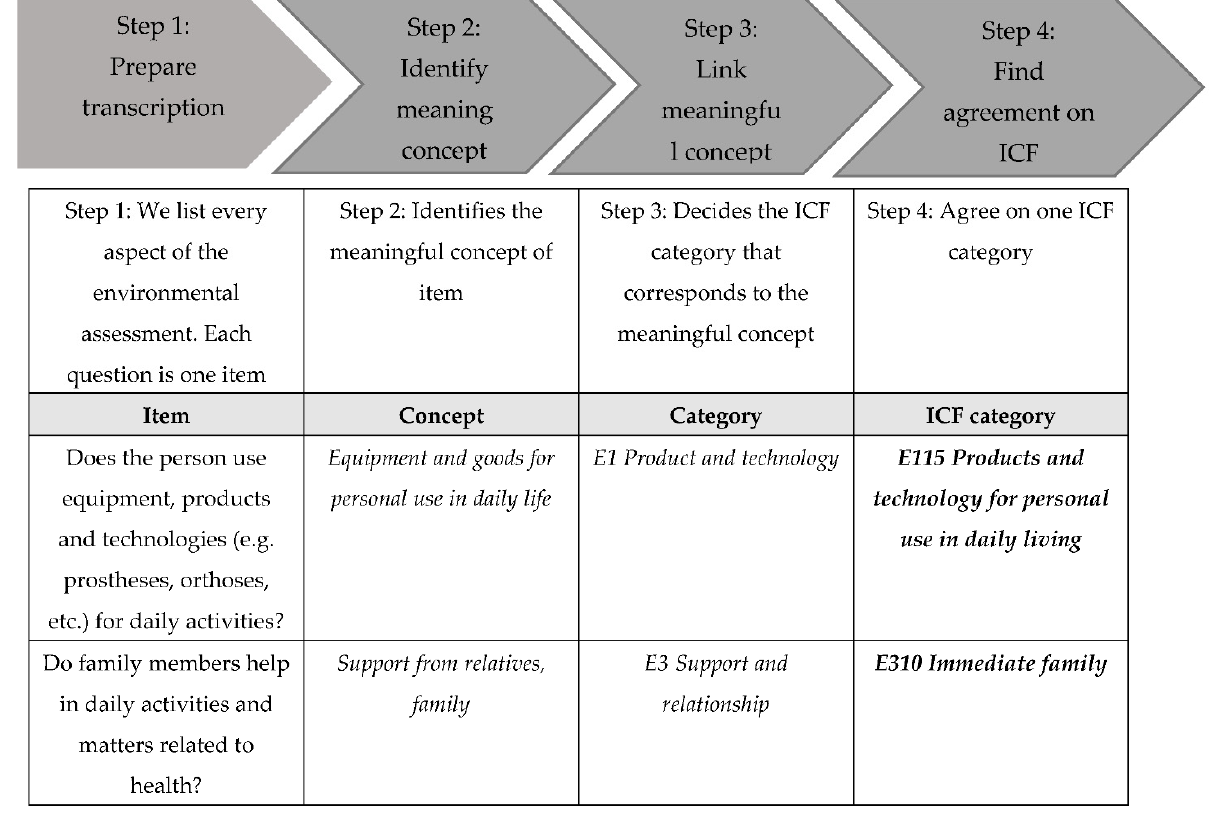
Figure 1. An illustration of the linking process.